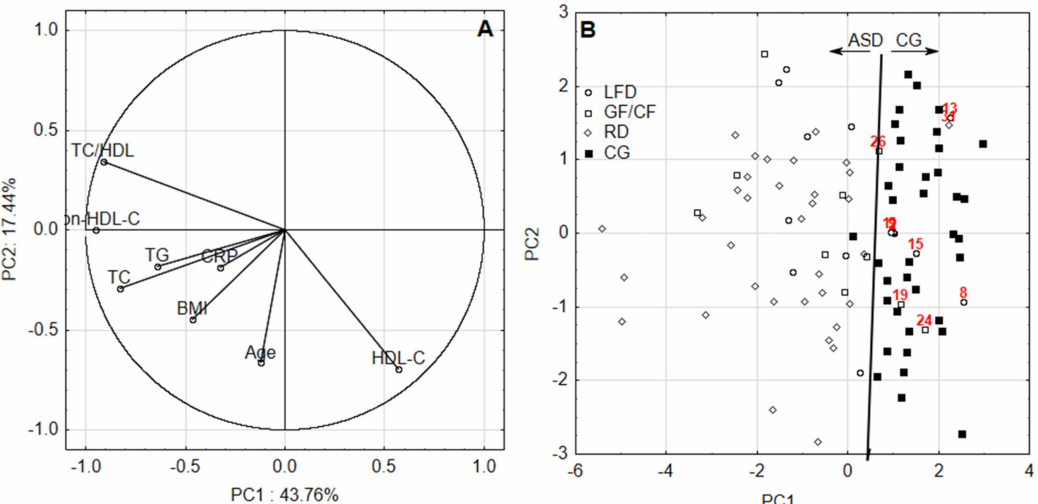
Figure 1. ( A ) The first principal component (PC1) and the second principal component (PC2) loadings and ( B ) scores for first data set; ASD—group, CG—control group, LFD—low-fat diet,